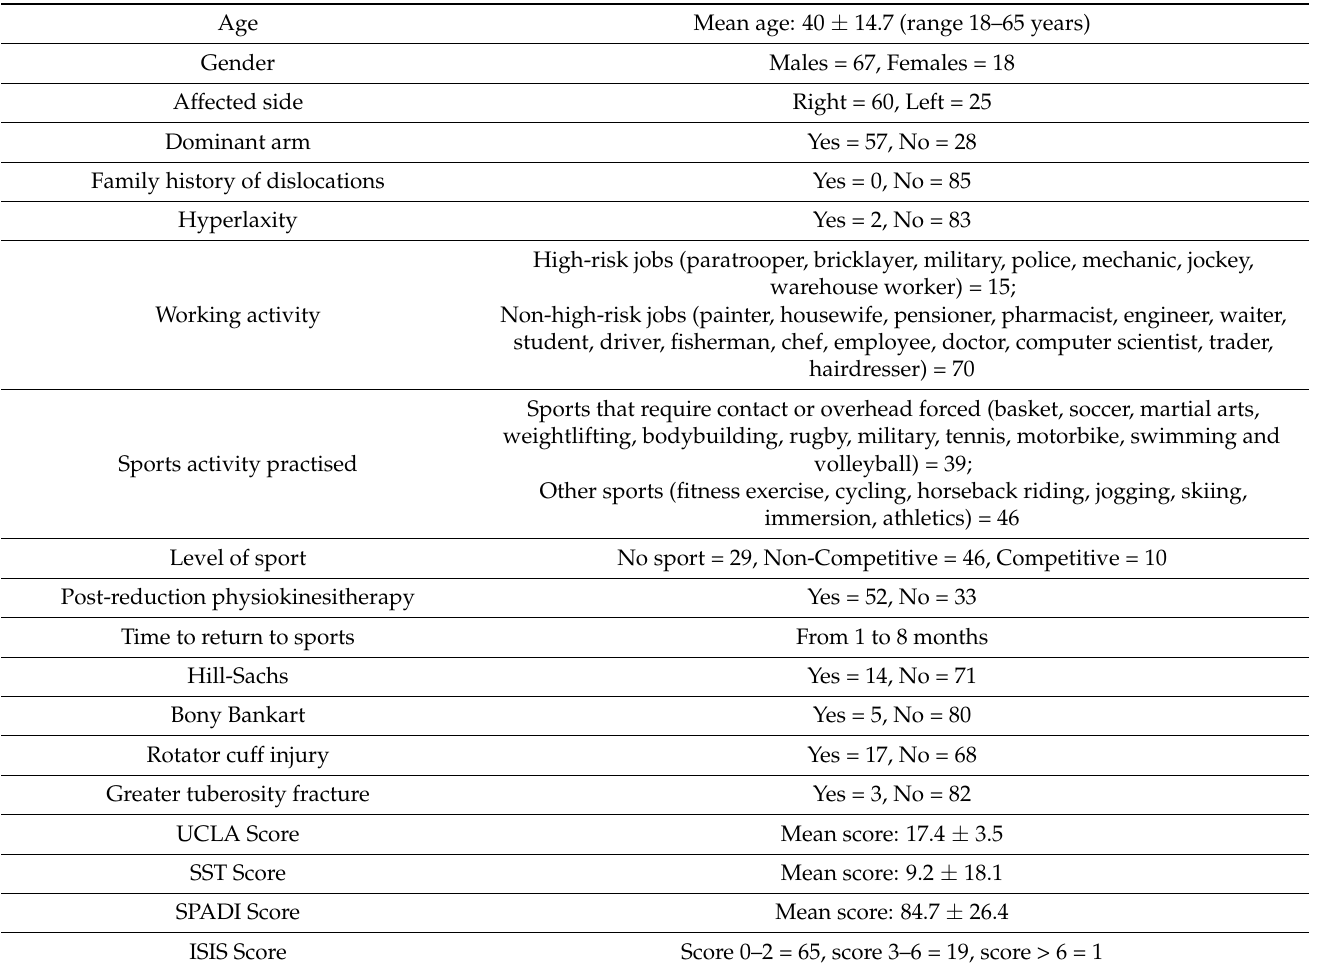
Table 2. Descriptive statistical analyses, frequencies and means of variables